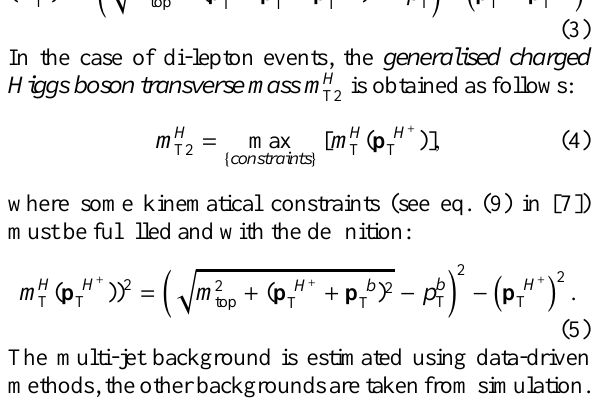
Fig. 3. Expected and observed limit with 95% C.L. of ( t H + b ) from τ + jets events as a function of m + B → comparison with the D0 experiment.